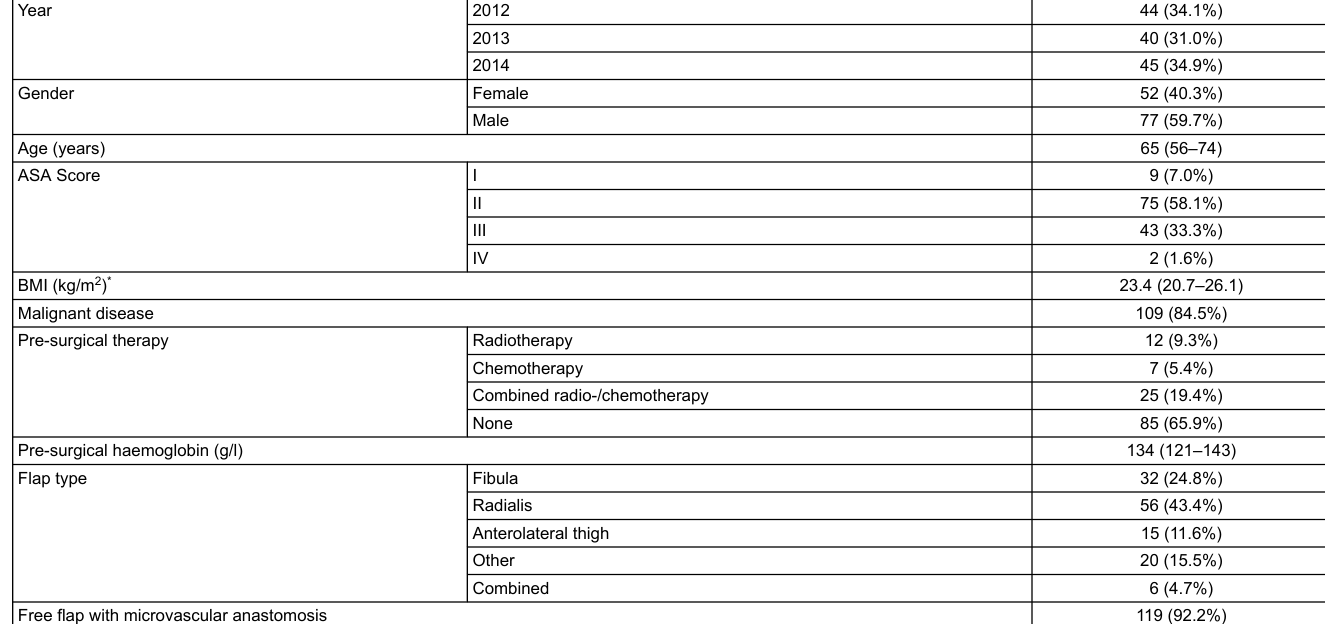
Table 1: Descriptive statistics of the patient cohort (n =